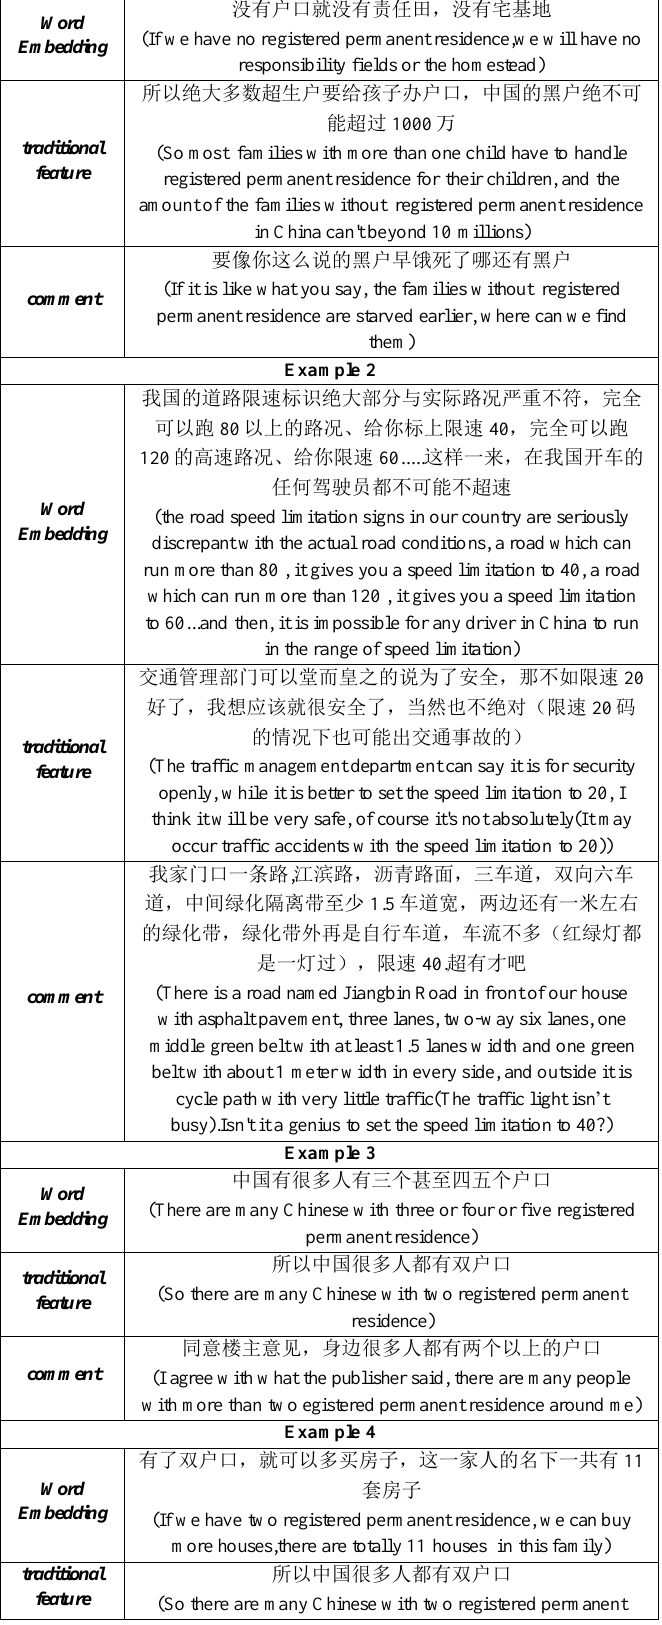
E XAMPLES OF L INKING R